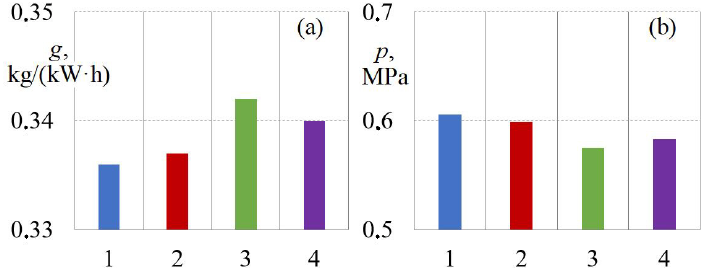
Figure 15. Diagrams of values of specific fuel flow g ( a ) and average cycle pressure p ( b ) of the engine in nominal mode for an intake system with channels of different diameters: 1— d = 20 mm; 2— d = 32 mm; 3— d = 40 mm; 4— d = 50 mm.